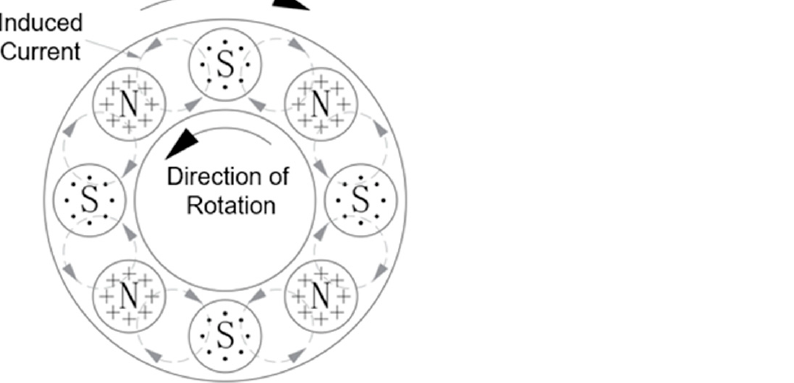
Figure 3. The damping torque and induced current of electromagnetic damper.